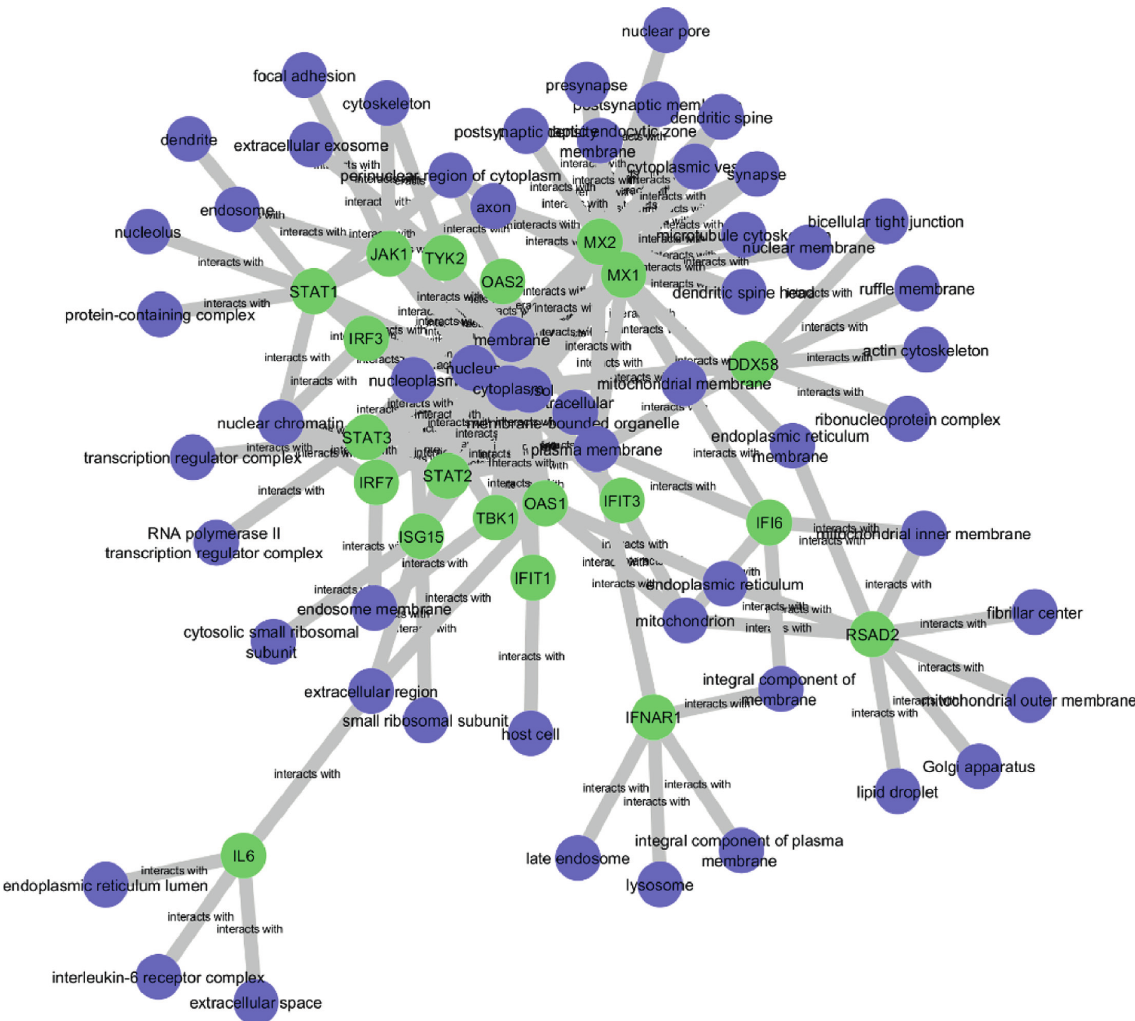
Figure 9: Bipartite graph of important protein-cellular